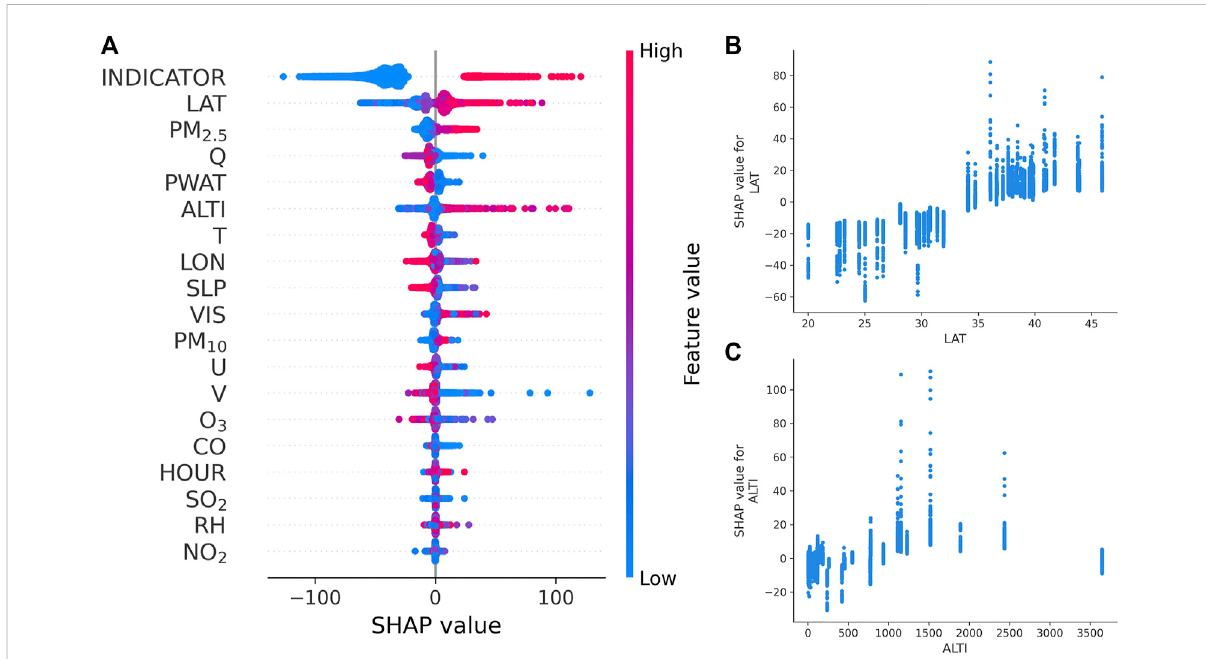
FIGURE 9 SHAP summary plot (A) , partial dependence plot of LAT (B) and partial dependence plot of ALTI (C) for the optimization of the 1st-day PM 2.5